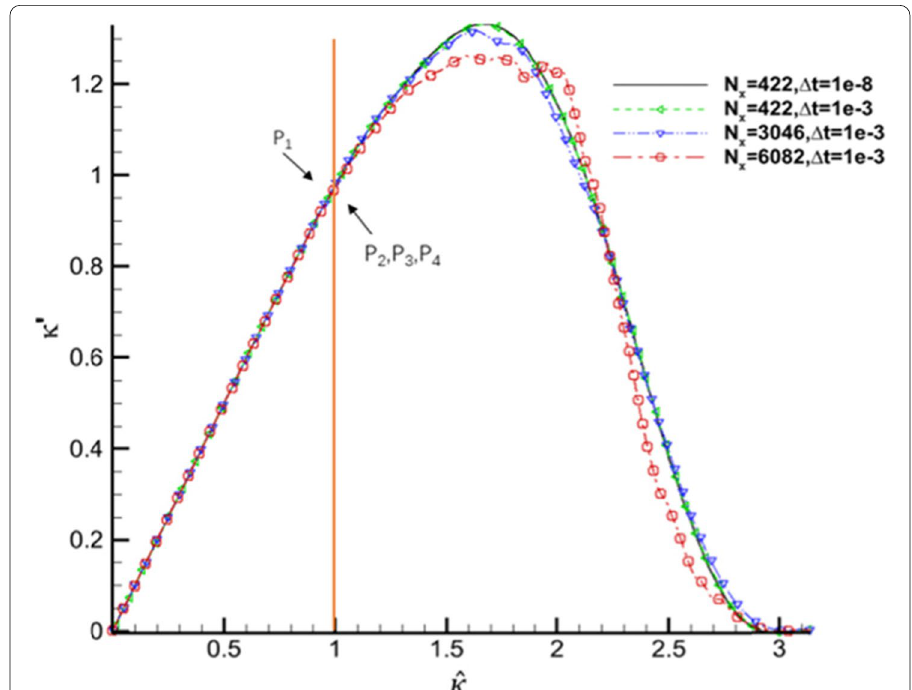
Fig. 4 Illustrations of P i on the distributions of Re( κ ′ ) for different sizes of grid and different time steps with WENO5-JS and